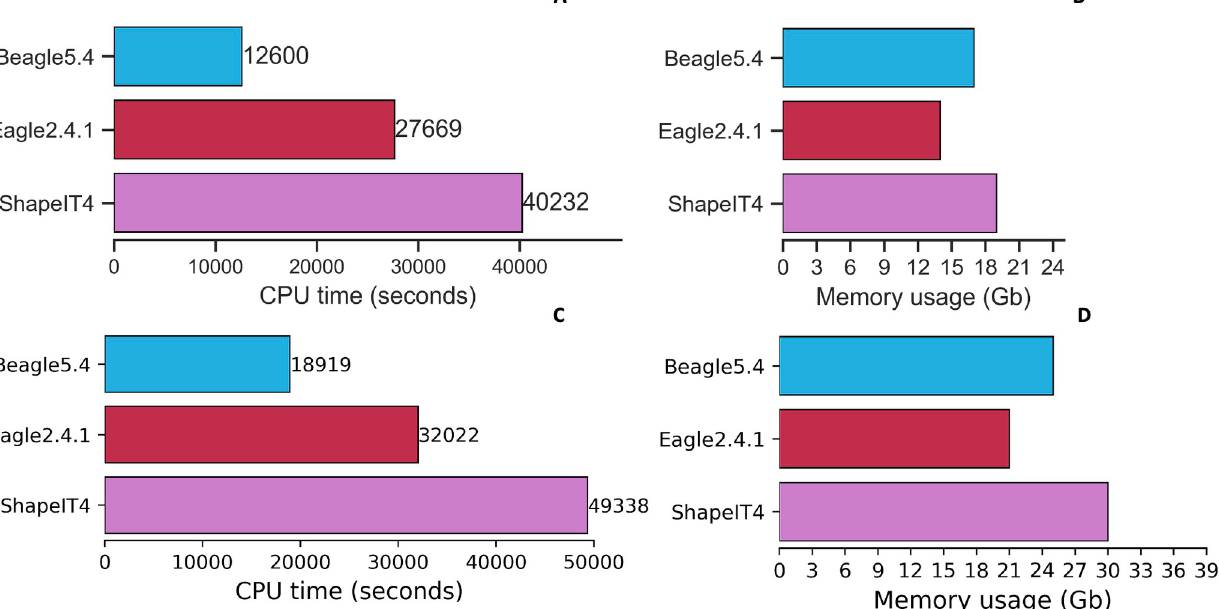
PLOS ONE | https://doi.org/10.1371/journal.pone.0260177 October 19,